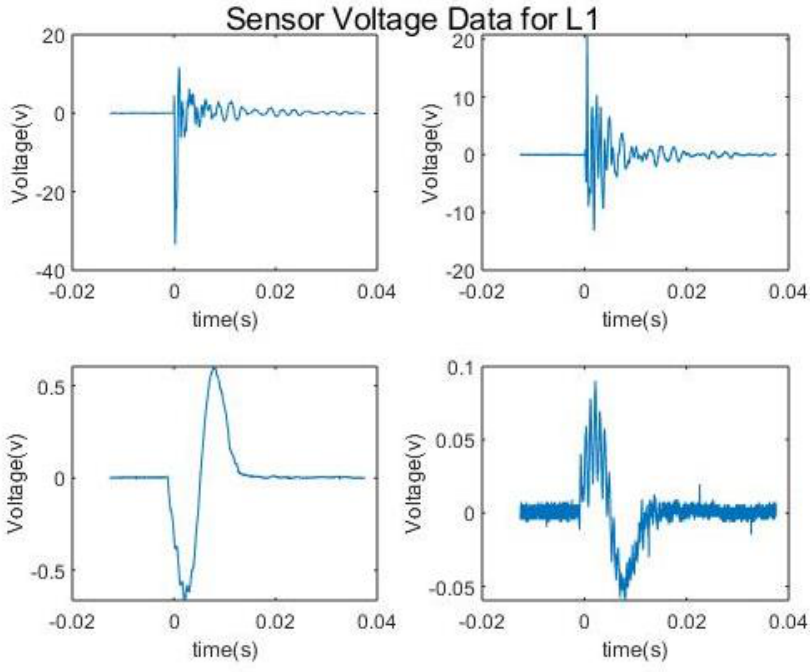
Figure 2. HI and SI for sensor 1 on the right and the HI and SI for sensor 8 on the left.